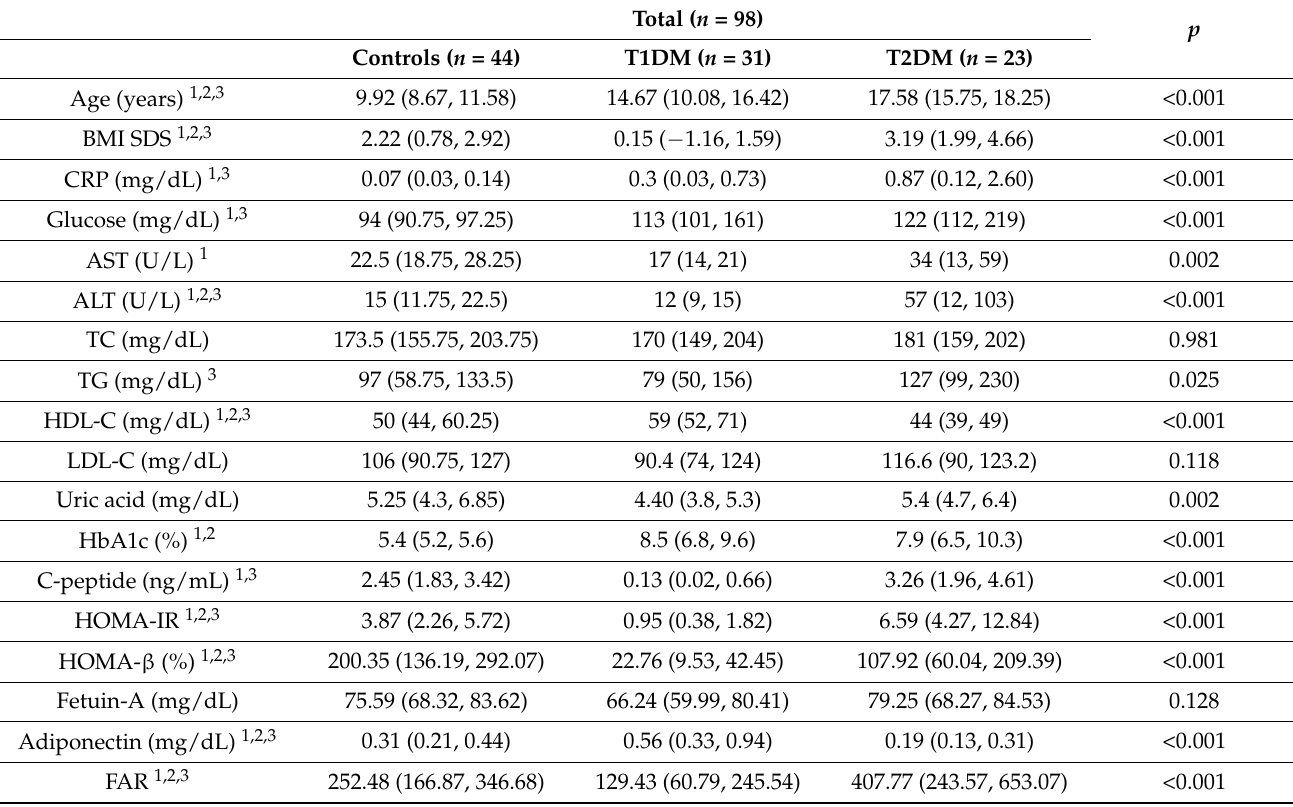
Table 3. Clinical and biochemical characteristics of the study participants with respect to the type of